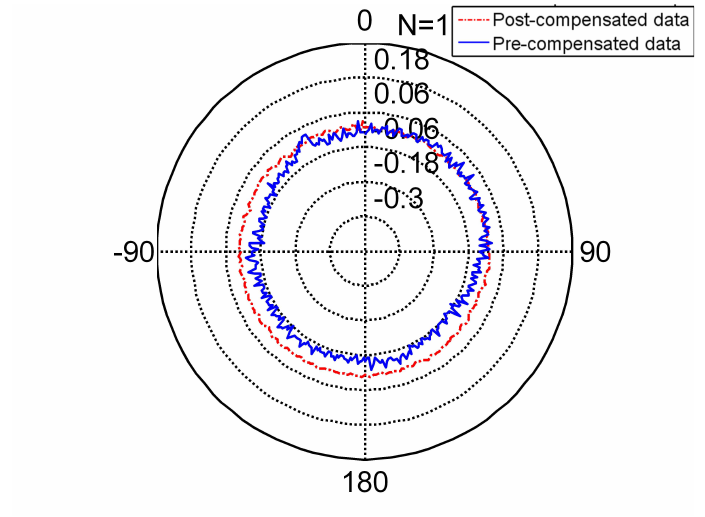
Figure 9. The non-separating method post-compensated data.